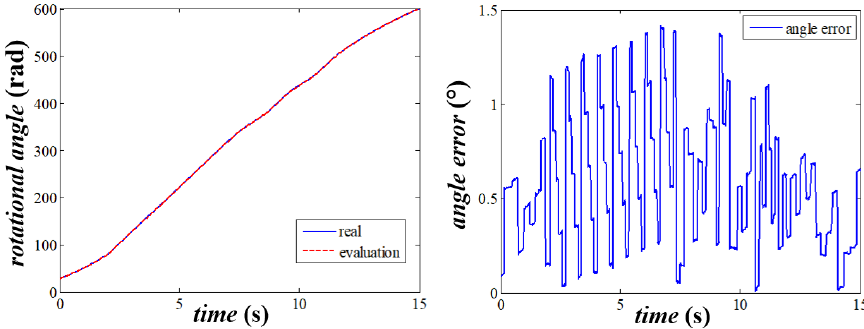
Figure 16. The results of the stand experiments.